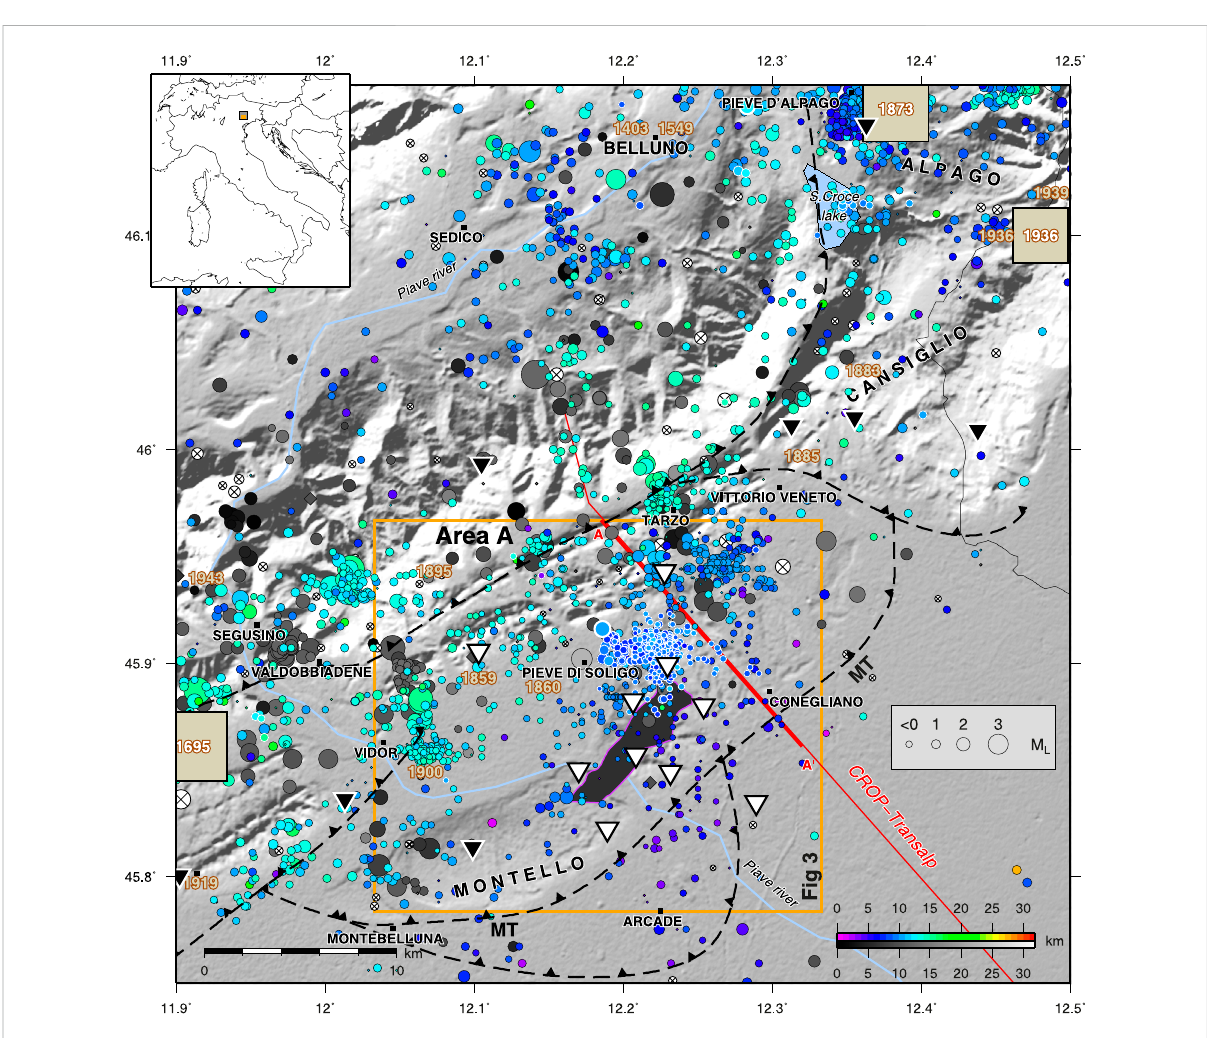
FIGURE 1 Seismotectonic framework of the August 2021 Refrontolo seismic sequence. Historical earthquakes (pale brown squares for M > 5.4, pale brownlabelsfor 4.5 < M < 5.5,taken fromCPTI15); earlyinstrumental hypocentrallocations (from 1977 to2011,takenfrom Romanoetal., 2019, gray color palette for depth), and earthquakes detected by the RSC network from 2012 to October 2021 (rainbow color palette for depth), uniformly located (H71, Lee and Lahr, 1975); white cross-hatched symbols are the less constrained solutions, with horizontal and vertical errors respectivelygreaterthan3and5 km.Thesizeoftheinstrumentalearthquakesymbolsisproportionaltothelocalmagnitude.The407eventsmarked with white circles occurred in August 2021 (this study) and are mainly located near Refrontolo (near Pieve di Soligo). Fault traces (black dashed lines) are taken from Burrato et al. (2008); MT is the Montello Thrust. In black with purple frame, the surface projection of the Collalto UGS, which is seismically monitored by the RSC network within the regional network managed by OGS (stations represented by white and black triangles, respectively). The orange square surrounding the Collalto UGS represents RSC target Area A. The red line is the trace of CROP -Transalp (Transalp Working Group, 2003; Fantoni and Franciosi,